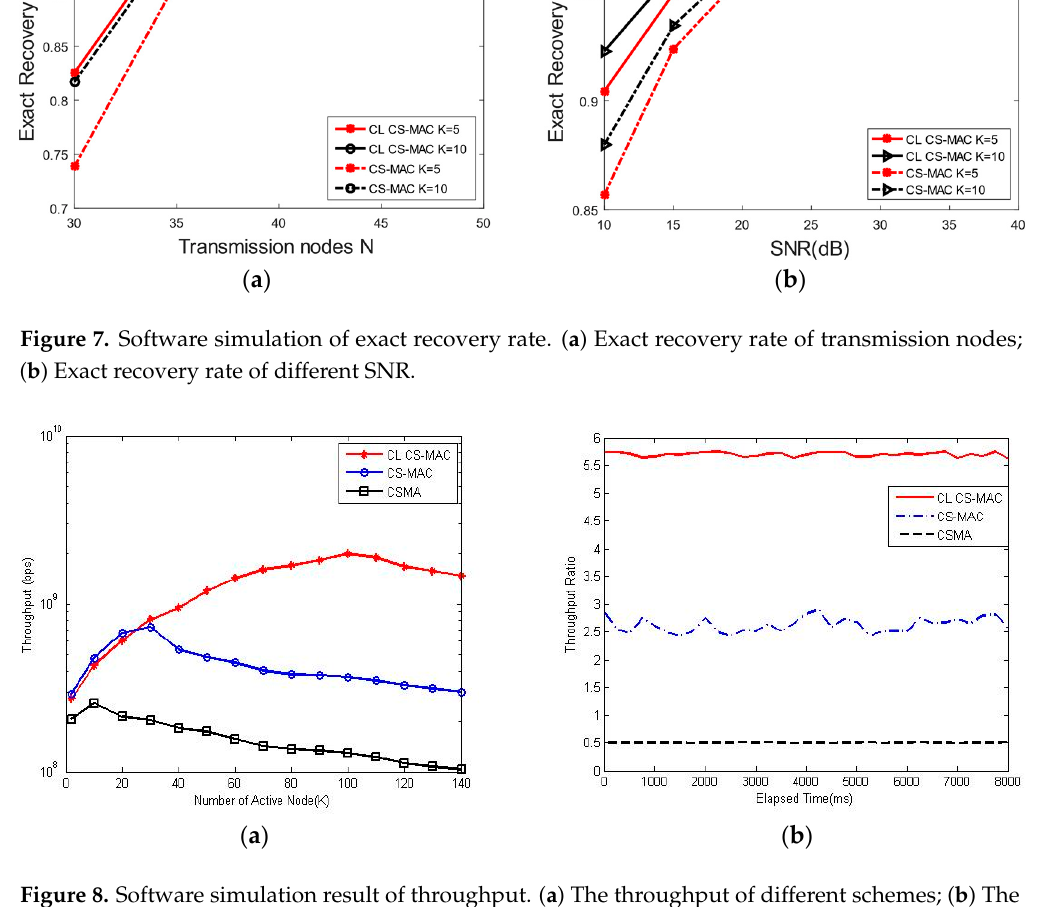
Figure 7. Software simulation of exact recovery rate. ( a ) Exact recovery rate of transmission nodes. ( b ) Exact recovery rate of different SNR.